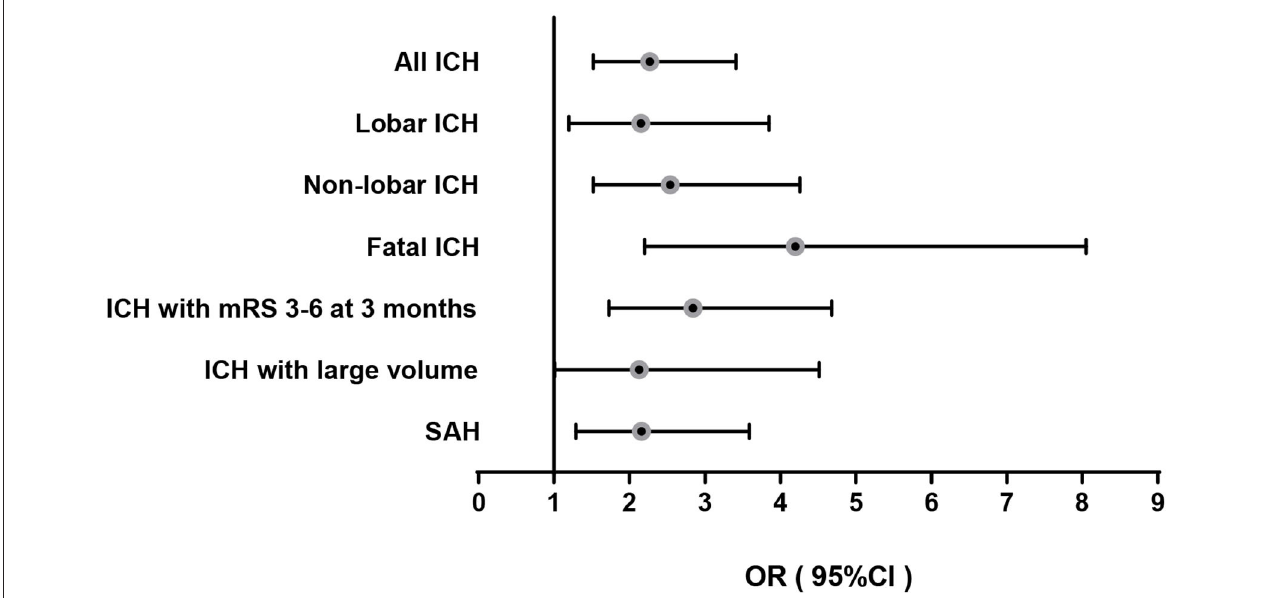
FIGURE 2 | Multivariable-adjusted odds ratio for ICH and SAH per 1 log unit increase of GDF-15.